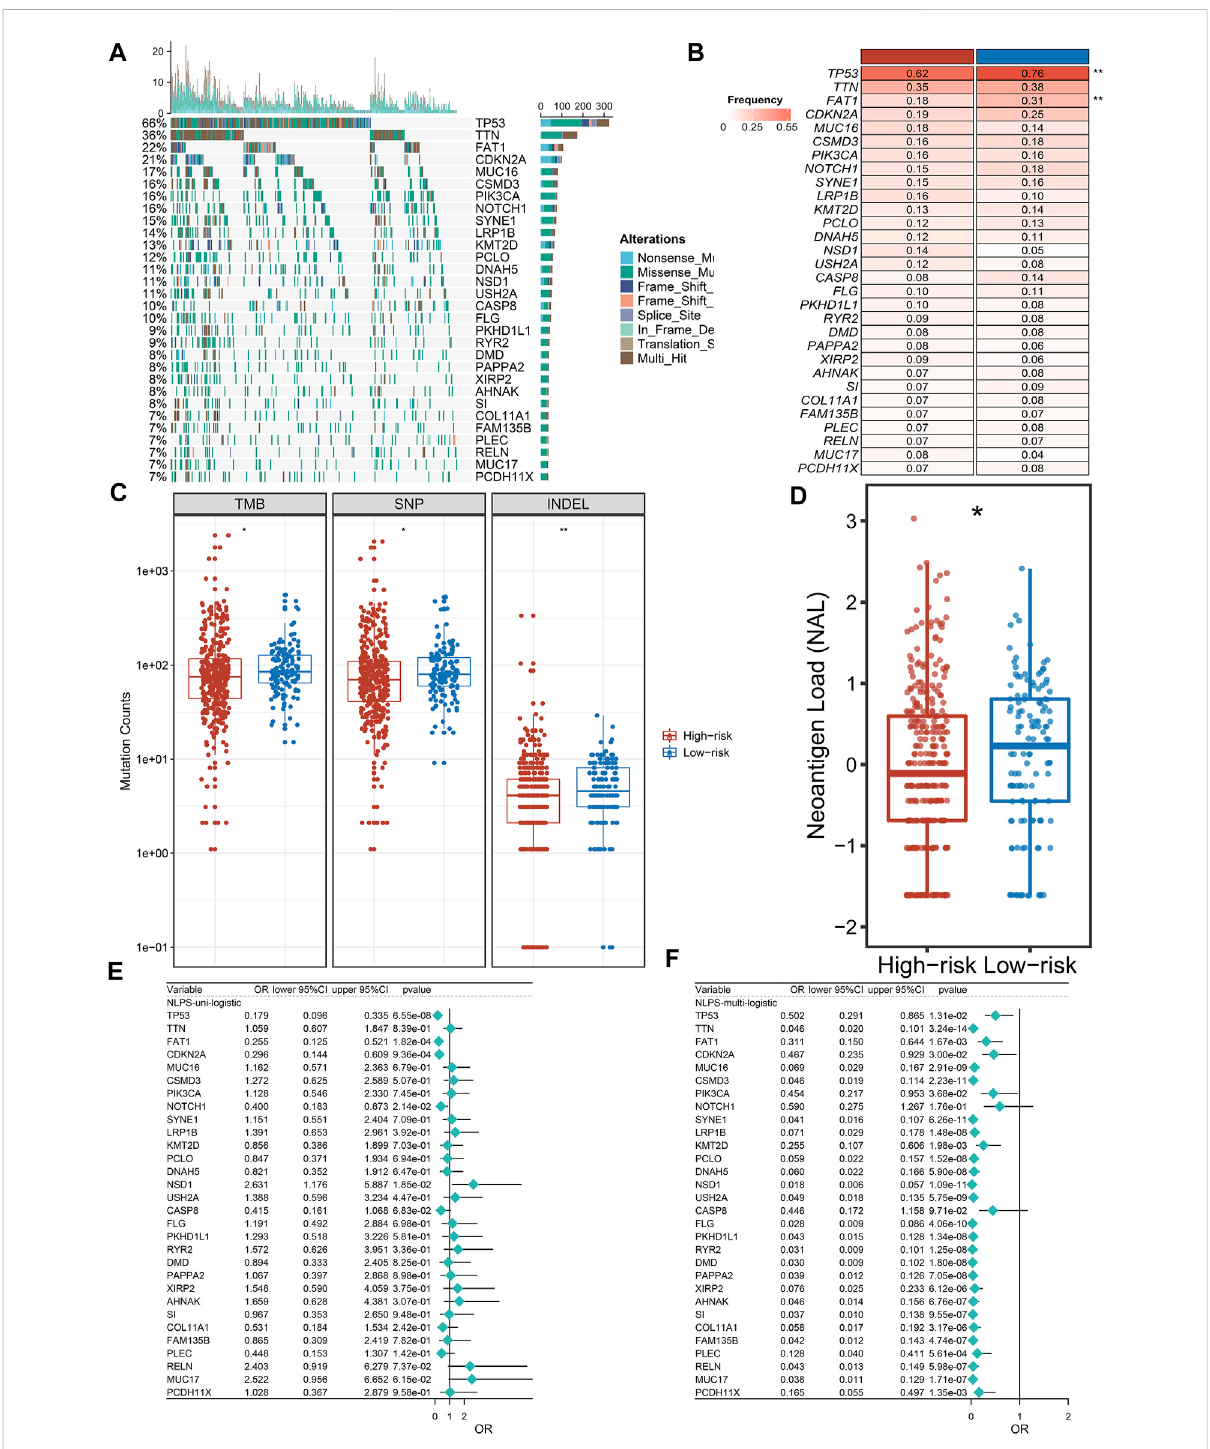
FIGURE 6 GenomiclandscapeofNLPS. (A,B) Mutationallandscape (A) andfrequency (B) ofthetop30FMGsbetweentwogroups. (C) TheamountofTMB, SNP,andINDELbetweentwogroups. (D) ThedifferenceofNALbetweenthehigh-andlow-risk. (E,F) Correlationbetweenthemutationstatusoftop 30 FMGs and NLPS. * p < 0.05, ** p < 0.01, *** p < 0.001, **** p <